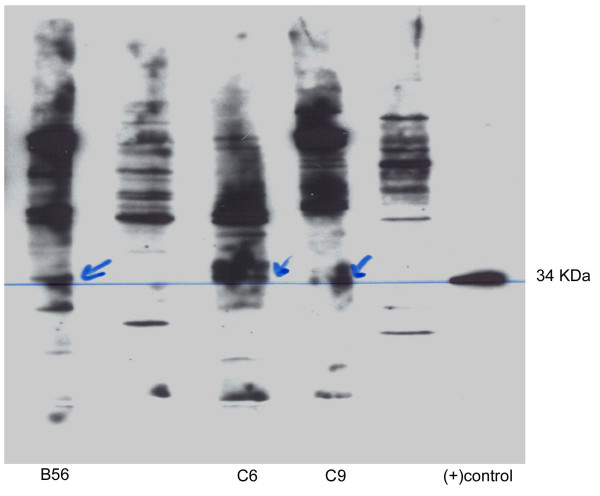
AFA in Rio-Rato serum samples Photograph of denaturing gel electrophoresis of 3 AFA positive samples from 41 ANoA positive serum samples previously determined by IIF. Fibrillarin = 34 Kda protein.